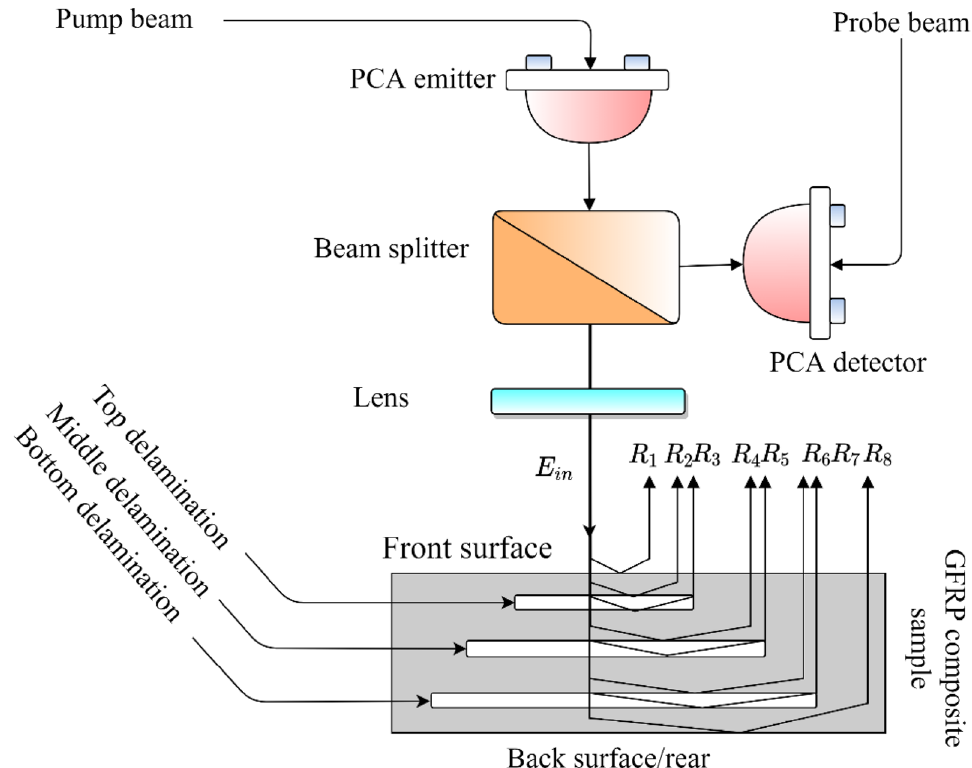
Figure 7 The propagation of the THz wave in multilayered GFRP composites with three levels of delamination defects. The denominations of the top, middle, and bottom delamination defects used to describe the different delamination levels are based on the propagation direction of the THz waves when passing through the GFRP composite sample as illustrated in this